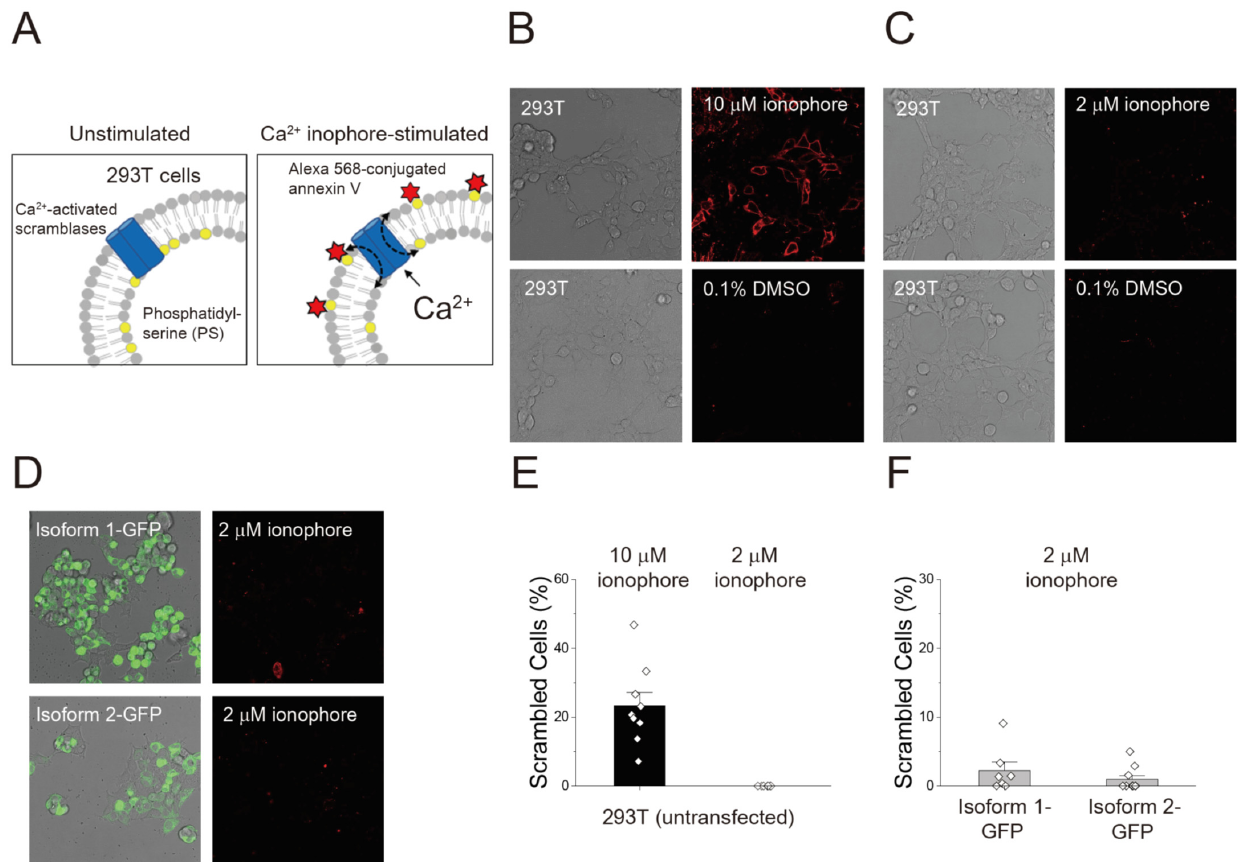
Figure 2. Scrambling activity of endogenous TMEM16F in 293T cells and the effect of GFP tagging on human TMEM16C. ( A ) Schematic diagram of cell-based imaging using fluorophore-labeled annexin V. Phosphatidylserine (PS) exposed by Ca 2+ -activated scramblase activity upon treatment with the Ca 2+ ionophore A23187 was stained with Alexa 568-conjugated annexin V. Accumulation of red signal was captured by microscope imaging. ( B ) Endogenous scrambling activity of TMEM16F in 293T cells. 10 µ M ionophore was added to 293T cells to increase intracellular Ca 2+ concentration. DMSO (0.1%) was used as a control. ( C ) Optimization of imaging conditions to minimize endogenous lipid-scrambling activity in 293T cells. 293T cells treated with 2 µ M ionophore showed minimal scrambling activity, equivalent to the control treatment. ( D ) Lipid-transporting activity of GFP-tagged human TMEM16C isoforms 1 and 2. 2 µ M ionophore was added to transfected 293T cells to increase intracellular Ca 2+ and stimulate TMEM16C activity. ( E ) Quantification of lipid-scrambling activity in 293T cells upon treatment with 10 µ M and 2 µ M ionophore. Data are presented as mean + standard error of the mean (SEM); n = 9 for 10 µ M ionophore and n = 8 for 2 µ M ionophore. ( F ) Quantification of lipid-scrambling activity of GFP-tagged TMEM16C isoform-transfected 293T cells after treatment with 2 µ M ionophore. Data are presented as mean + SEM; n = 7 for isoform 1-GFP and n = 10 for isoform